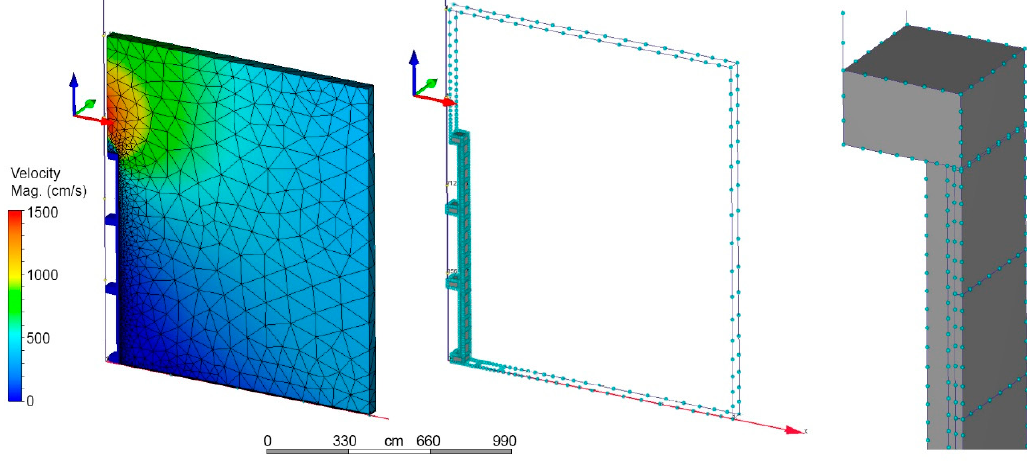
Figure 2. Enabled automatic mesh sizing for the model.